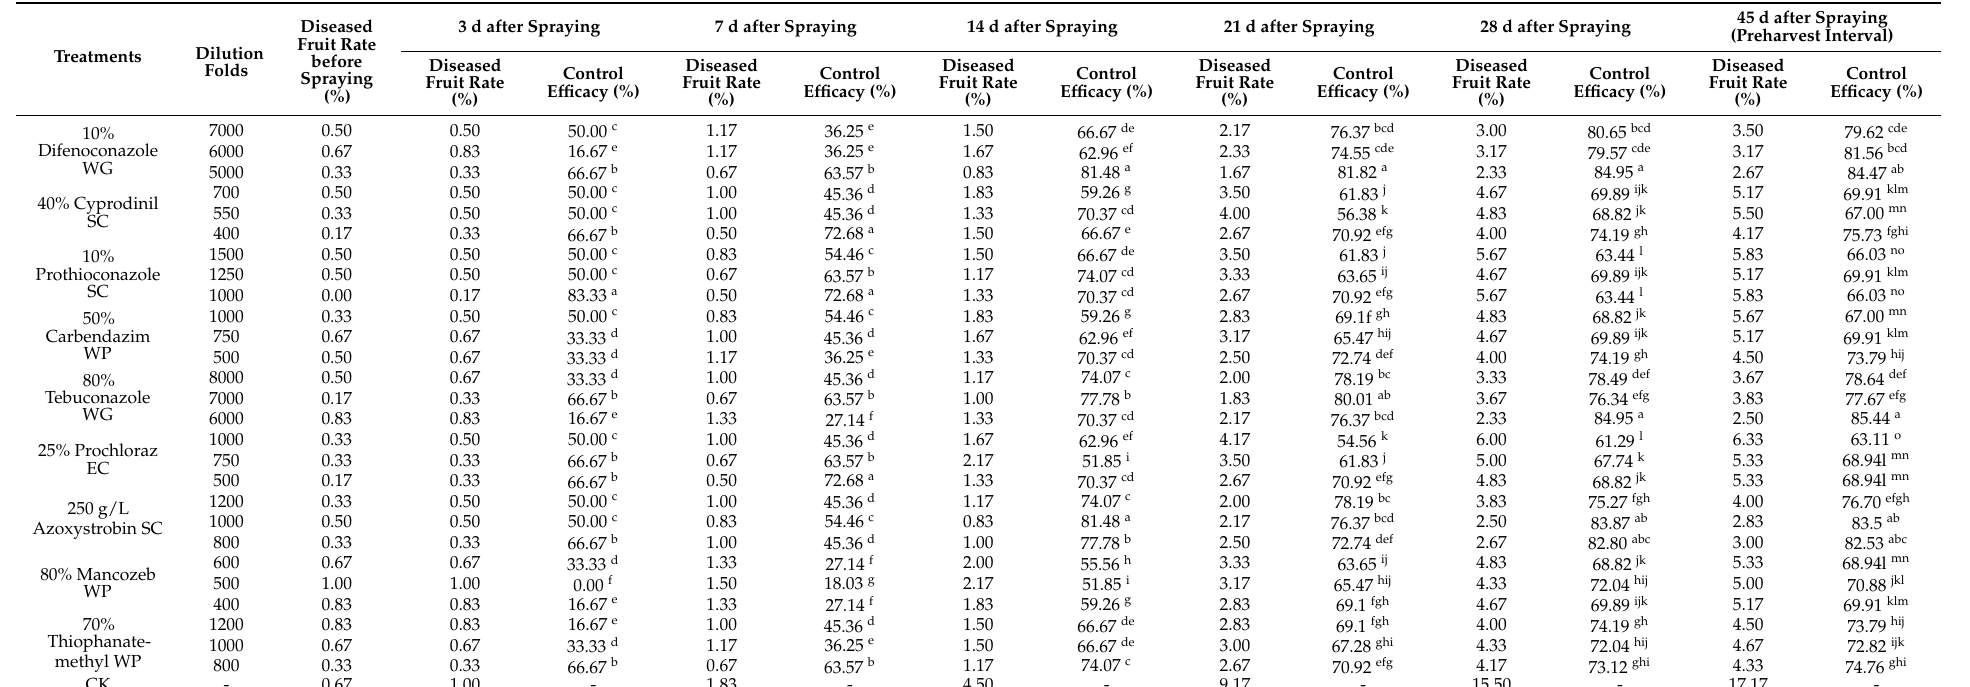
Table 5. The control effect of nine fungicides on top rot in R. roxburghii